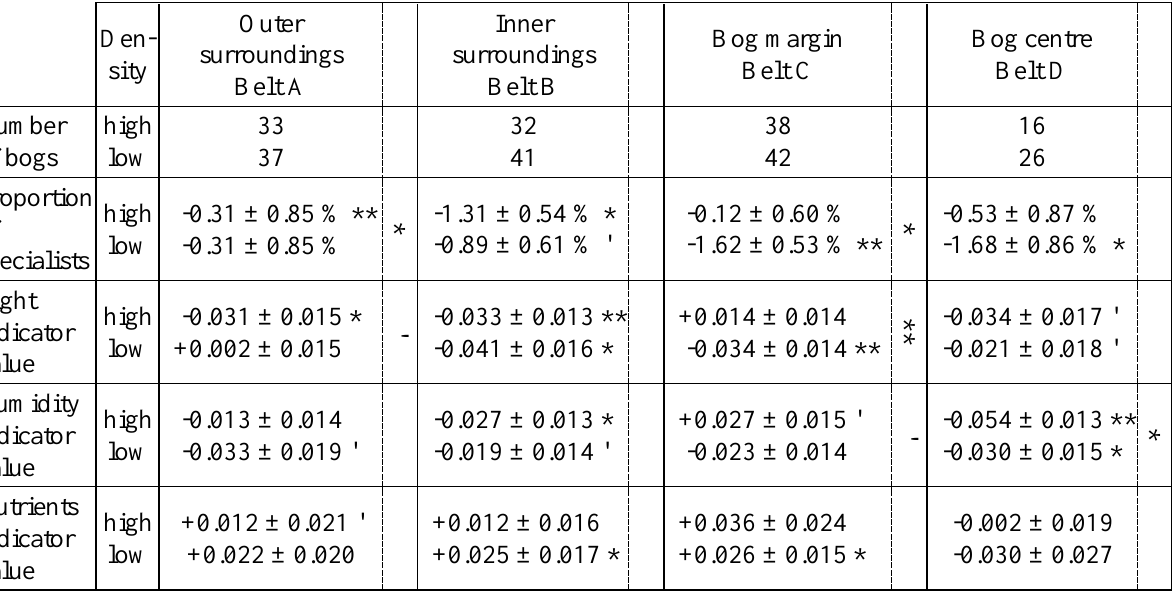
Table 8. Changes of bog quality in Belts A, B, C and D, in relation to bog density, between the first and second surveys. Significance levels for the changes themselves (signed rank sum test), and for the differences between high and low density (rank sum test): *** < 0.001, ** <0.01, * <0.05, ' <